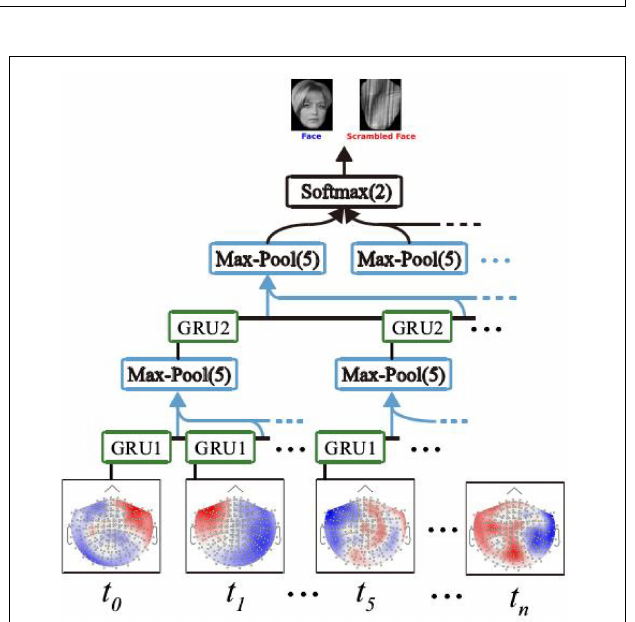
FIGURE 3 | Recursive neural network based on gated loop unit GRU. Human image reproduced with permission from the TikTok dataset.